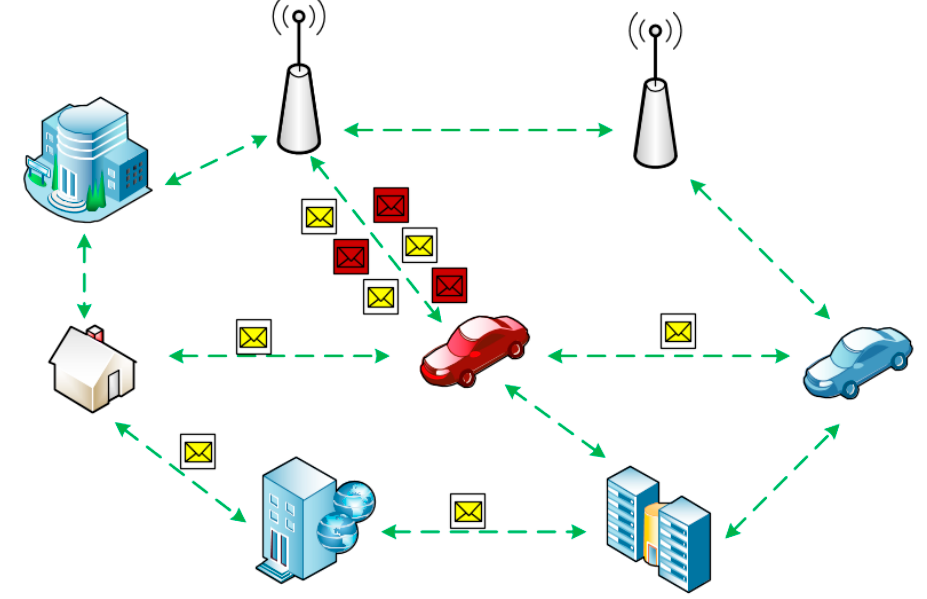
Figure 6. The gray hole attack case.